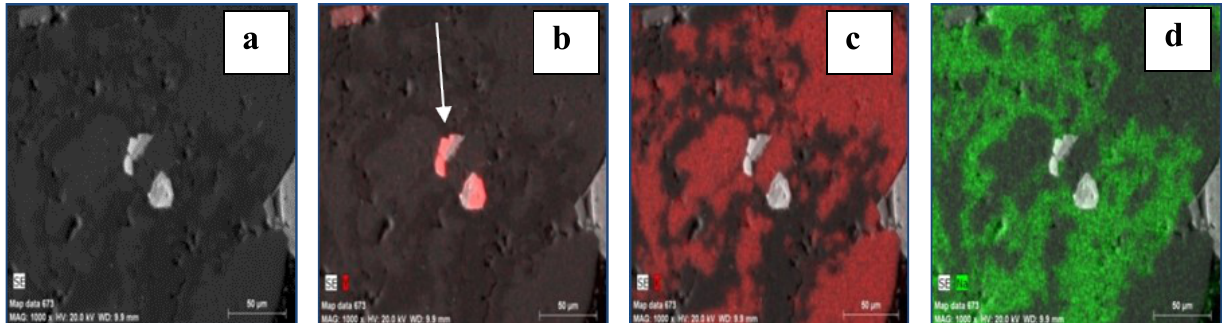
Fig. 13. Yttrium and Na-K distribution patterns. a. General view, b. yttrium, c. potassium, d. sodium distribution patterns